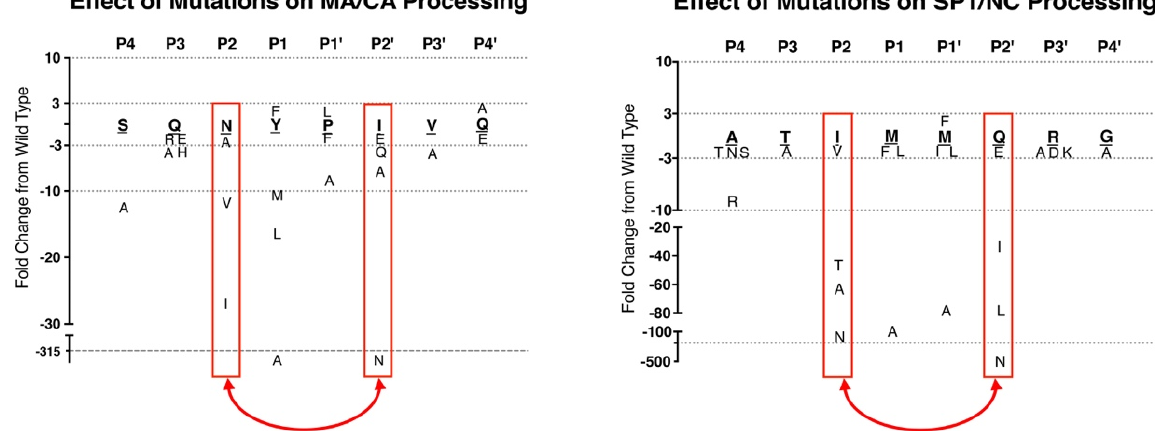
Figure 5. Relative Rates of Protease Cleavage of SP1/NC and MA/CA Cleavage Sites with Substitutions. The wild-type sequence is shown in bold and underlined (MA/CA: SQNY/PIVQ ; SP1/NC: ATIM/MQRG ). The substitutions are shown above or below in single-letter amino acid code. The change in the rate of cleavage relative to wild type is shown by the vertical positioning of the indicated substitution, with faster rates above the wild-type sequence and slower rates below, as indicated by the Y -axis label. Changes within three-fold represent little to no change. The P2 and P2’ positions are indicated by the red rectangles. The red double-headed arrow notes the change in specificity in P2 and P2’. Data are reproduced from ref [79].